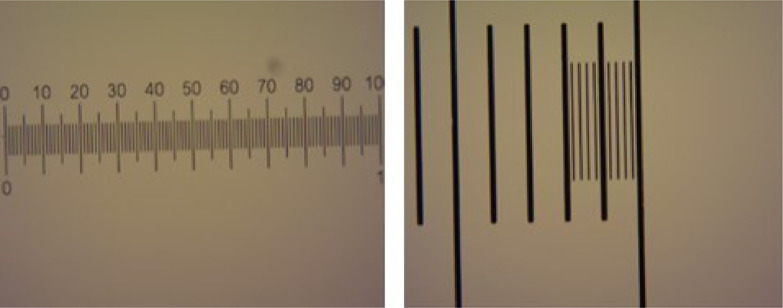
Micrometric scales.